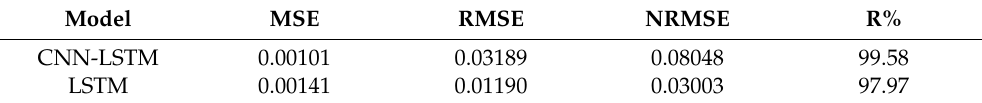
Table 2. Deep learning results for predicting the closing price of Tesla during the training phase. Model MSE